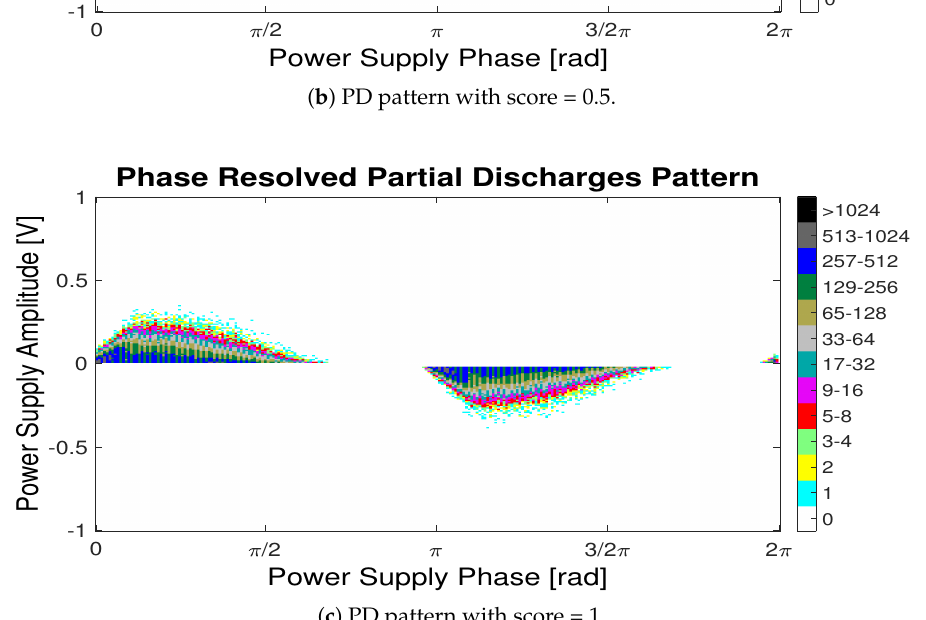
( b ) PD pattern with score = 0.5.